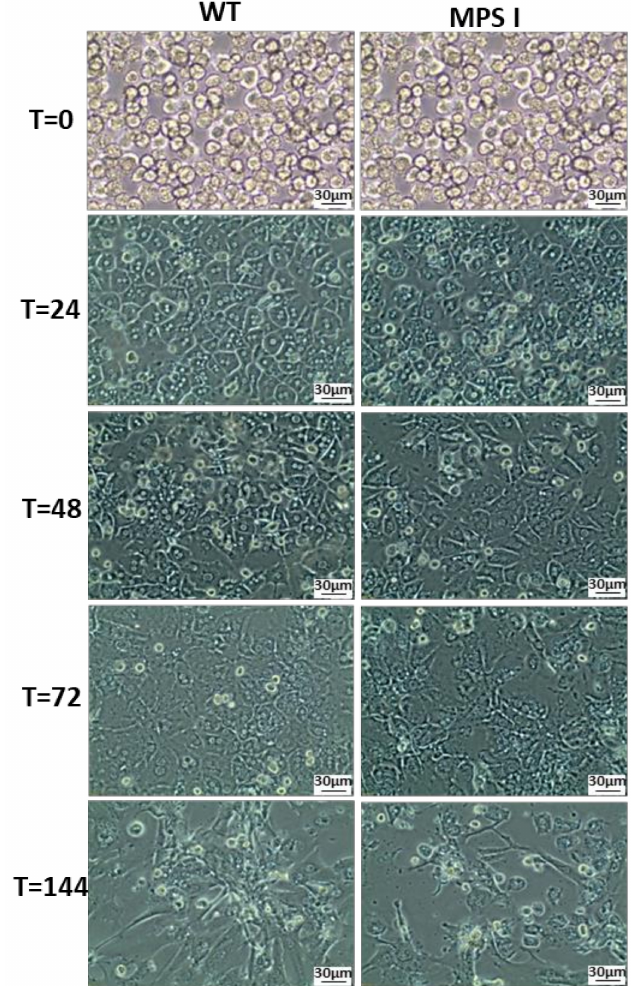
Figure 2. Morphology of wild type (WT) and mucopolysaccharidosis I (MPS I) murine primary hepatocytes. Microphotographs show cell morphology at several time points during cell culture. T = 0 hepatocytes at the beginning of culture when they do not attach to the bottom of the dish and after 24, 48, 72, and 144 h of